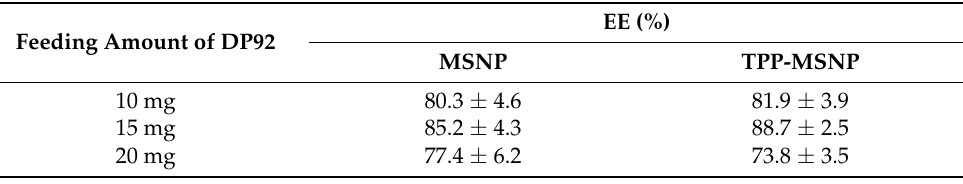
Table 2. Encapsulation efficiency (%EE) of DP92 in MSNP or TPP-MSNP. Data are presented as mean ± SD ( n = 3).